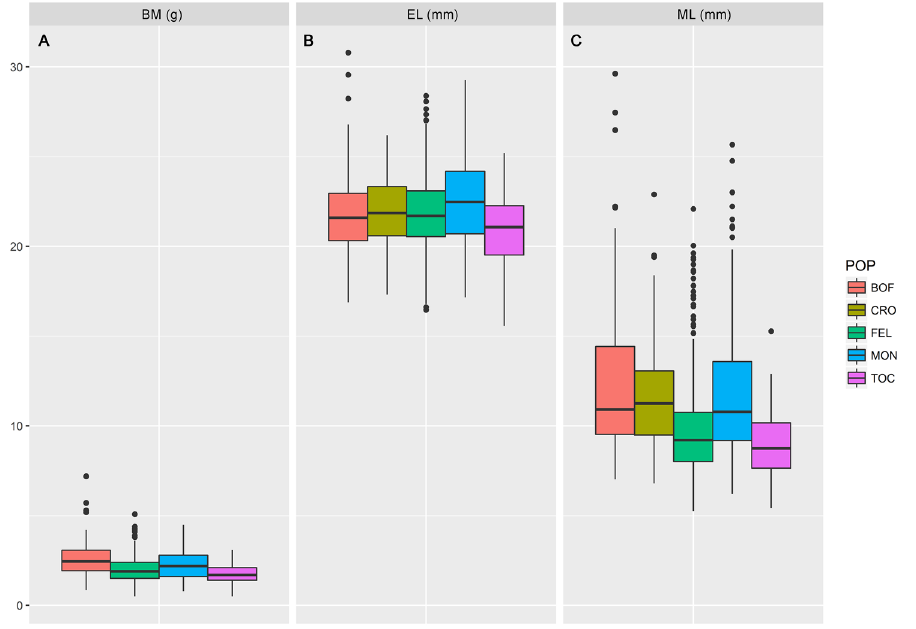
Figure 5. Box-plots for the variation in biometric rough variables, between populations: body mass (BM), elytron length (EL) and mandible length (ML). See Figure 1 for the acronyms of the study